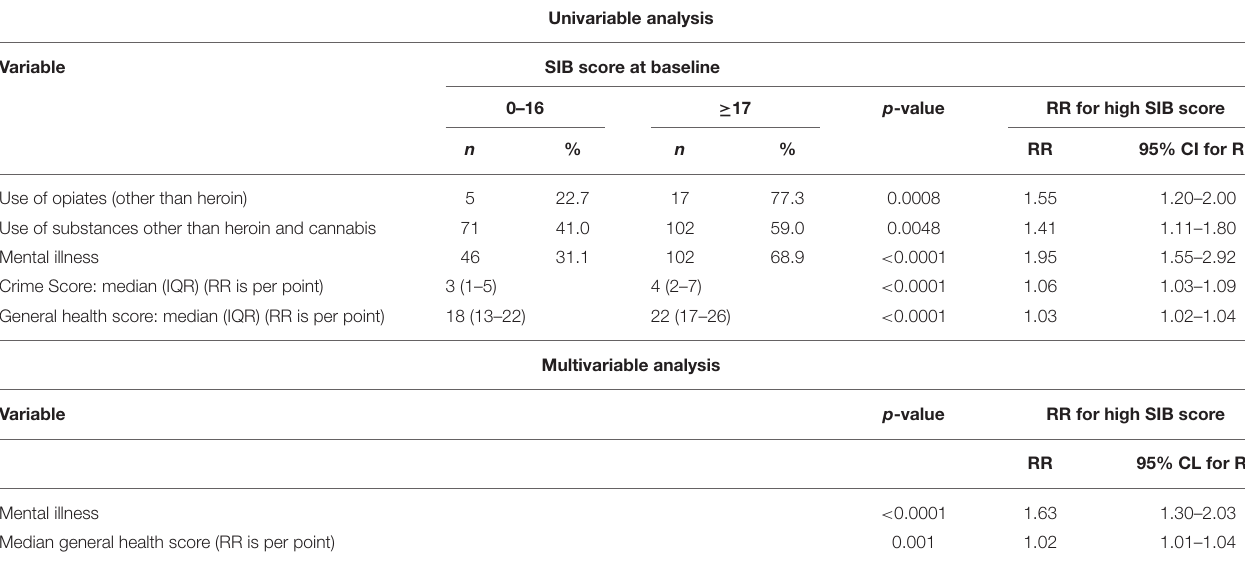
TABLE 3 | Factors significantly associated with a high SIB score at